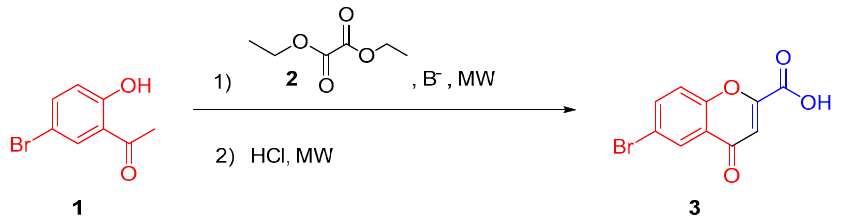
Table 1. Microwave-assisted optimization conditions for the synthesis of compound 3